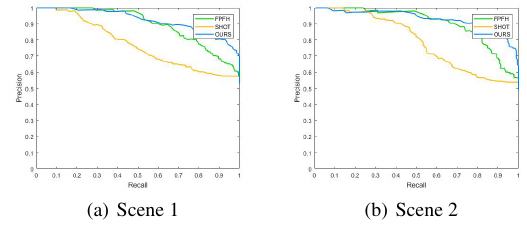
Figure 7. The PR curves of different descriptors on the two test scenes.